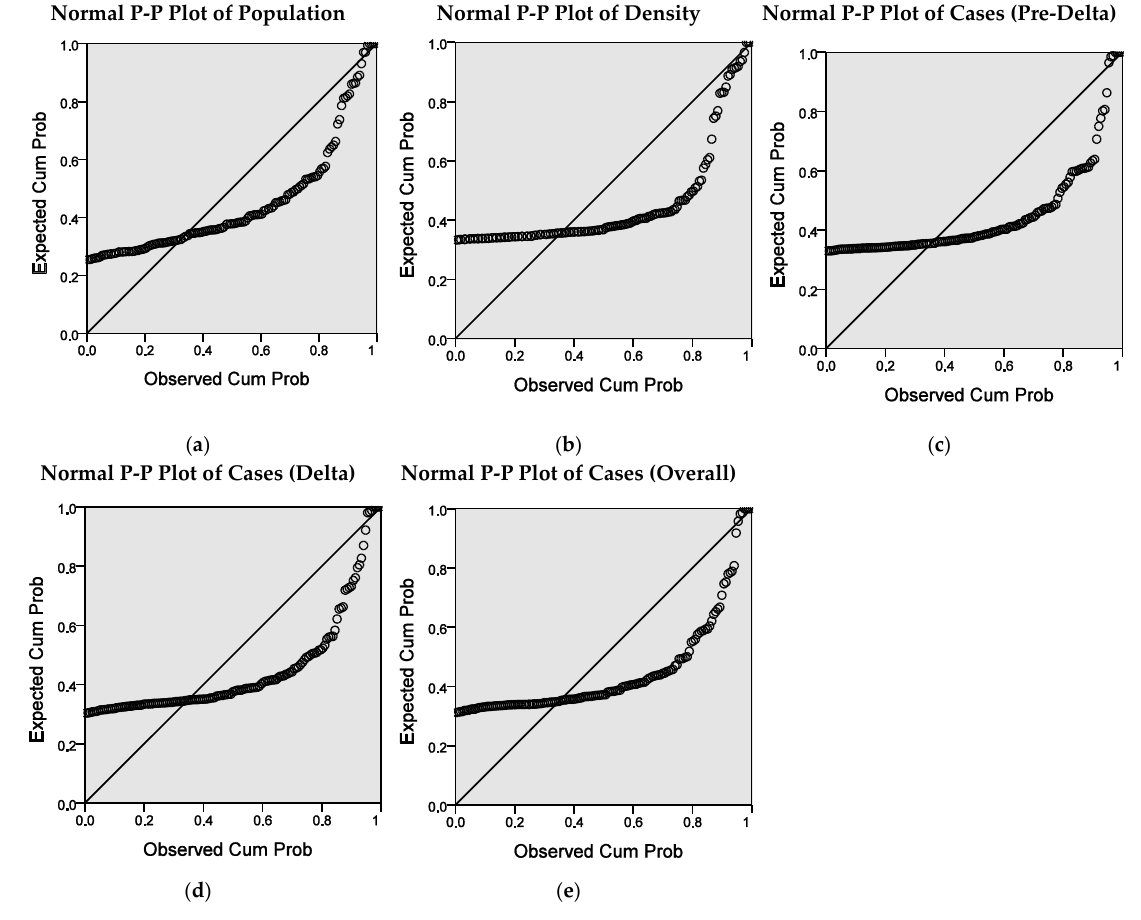
Figure A1. Normal P – P Plot, ( a ) Population, ( b ) Density, ( c ) COVID-19 cases during pre-Delta Figure A1. Normal P–P Plot, ( a ) Population, ( b ) Density, ( c ) COVID-19 cases during pre-Delta variant, variant, ( d ) Delta variant period, ( e ) Overall period. ( d ) Delta variant period, ( e ) Overall